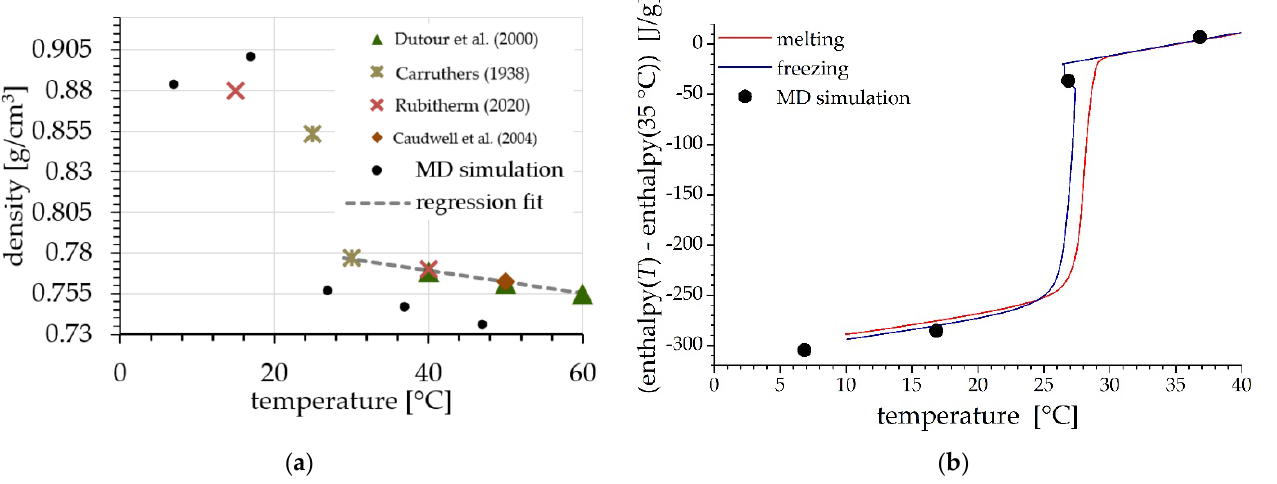
Figure 2. ( a ) density values for C18 from literature, the authors’ own experiments and MD simula- tion as well as regression fit from density values of the liquid state (dotted line) ( b ) enthalpy curve of C18 obtained by DSC measurement and MD simulation with reference to the enthalpy at 35 °C.